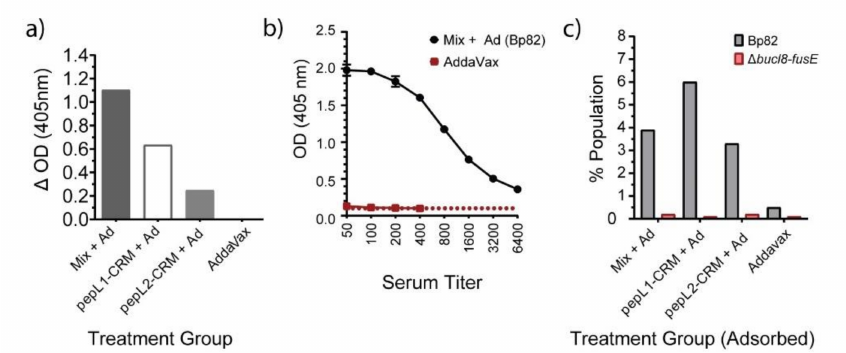
Figure 5. Antigen-specific IgG binding to Burkholderia . ( a ) Immune mouse sera recognize target bacteria by whole-cell ELISA. Wells were coated with ~10 4 cells, either Bp82 or Bp82 ∆ bucl8-fusE . Sera from mice immunized with peptide antigens (pepL1, pepL2, Mix) were pre-adsorbed with Bp82 ∆ bucl8-fusE mutant cells before completing the ELISA, then added to wells at a 1:50 dilution. Immunoreactivity obtained in wells coated with mutant cells was subtracted from the corresponding wells coated with Bp82. α -IgG secondary, 1:1000 dilution. ( b ) Concentration-dependent antigen recognition. Serial two-fold dilution of serum obtained from the Mix + AddaVax was tested against whole cell Bp82. Titers were completed as described in Figure 4, using adsorbed sera. ( c ) Immune mouse sera recognize target bacteria by flow cytometry analysis. Pre-adsorbed sera were incubated with either bacteria, labeled.